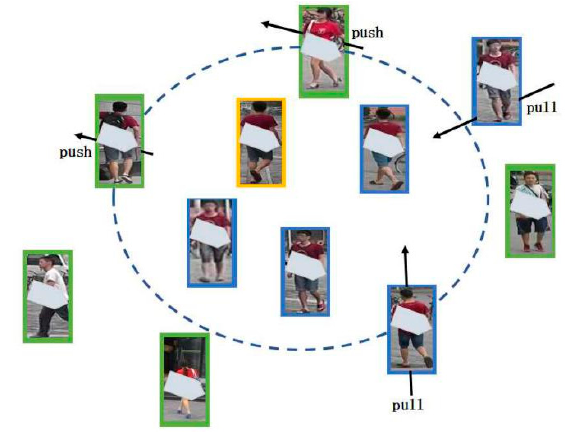
Figure 4. Similar classes are drawn closer and dissimilar classes are pushed away.